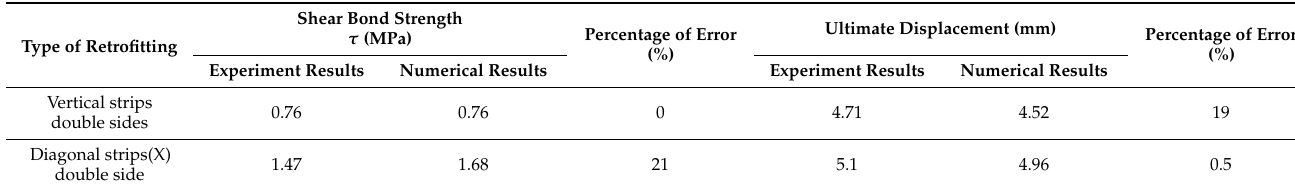
Comparison between numerical results and experiment data for reinforced shear triplet